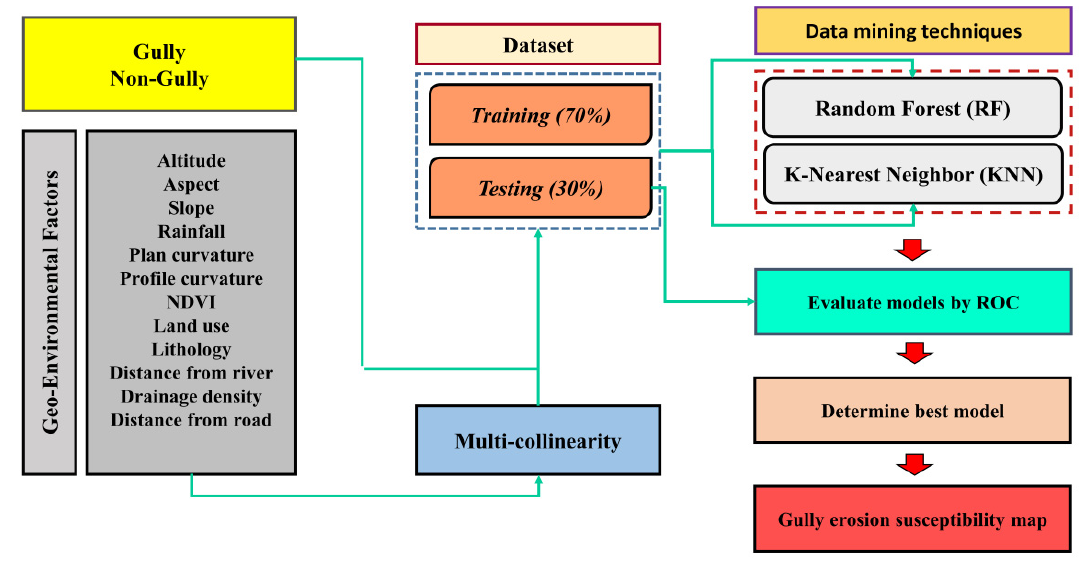
Figure 3. Flowchart of the research methodology used to provide the gully erosion susceptibility map.